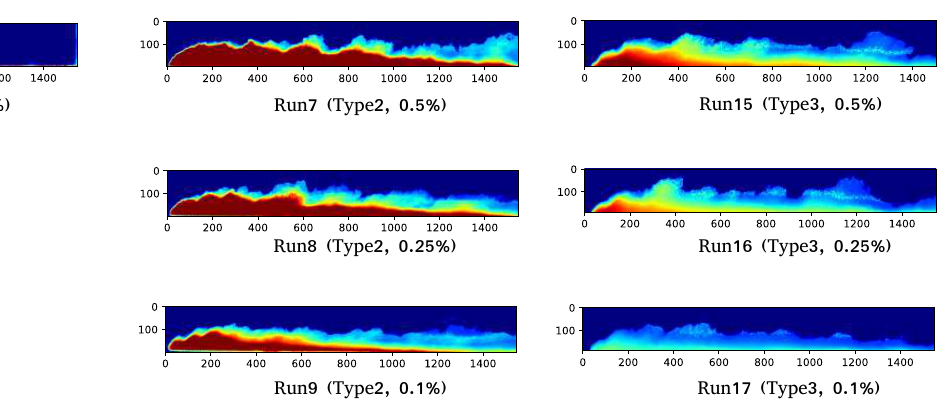
Figure 9. Comparison of the concentration distribution of the currents. The rows represent the same initial concentration and the columns represent the same sediment type. All the runs are acquired at the same front